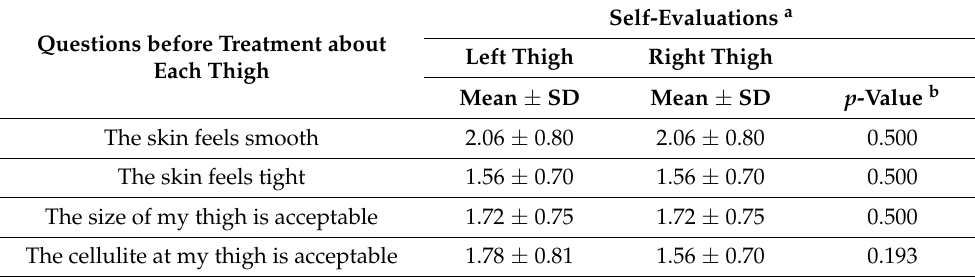
Table 2. Pre-trial participant self-evaluation questionnaire about their thighs.